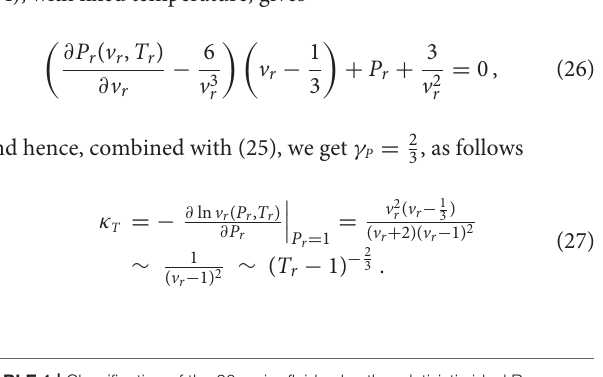
TABLE 1 | Classification of the 20 major fluids plus the relativistic ideal Bose gas and the van der Waals fluid, according to the critical indices: n − for T < T c and n + for T > T c